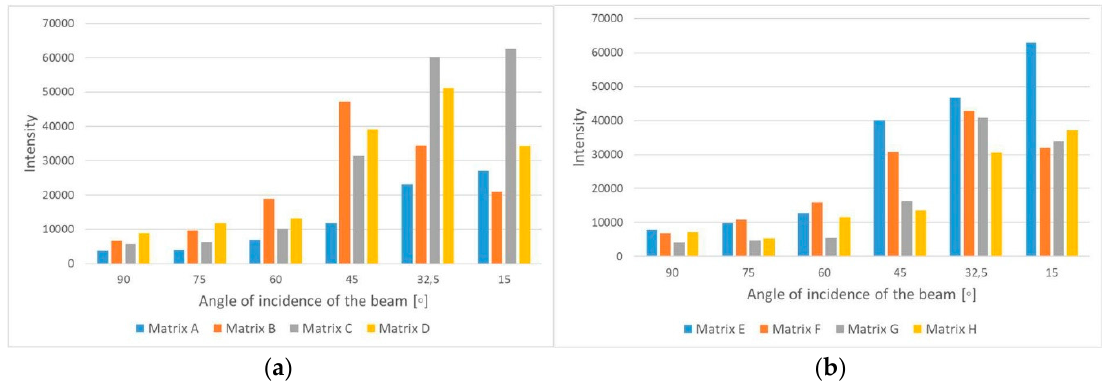
Figure 3. Dependence of the light beam intensity measured at the edges of the substrate for different angles of incidence ( α ) of the beam on the glass surface for various configuration of prisms’ matrix ( a ) of height 350 µm and ( b ) 250